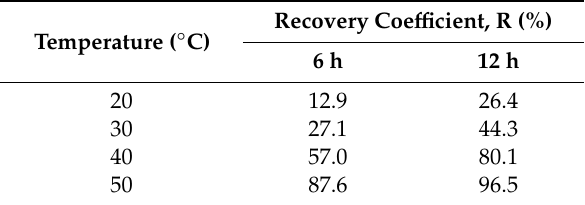
Table 7. Recovery coe ffi cient (R, %) of Cu(II) ions after 6 h and 12 h depending on the temperature. Temperature ( ◦